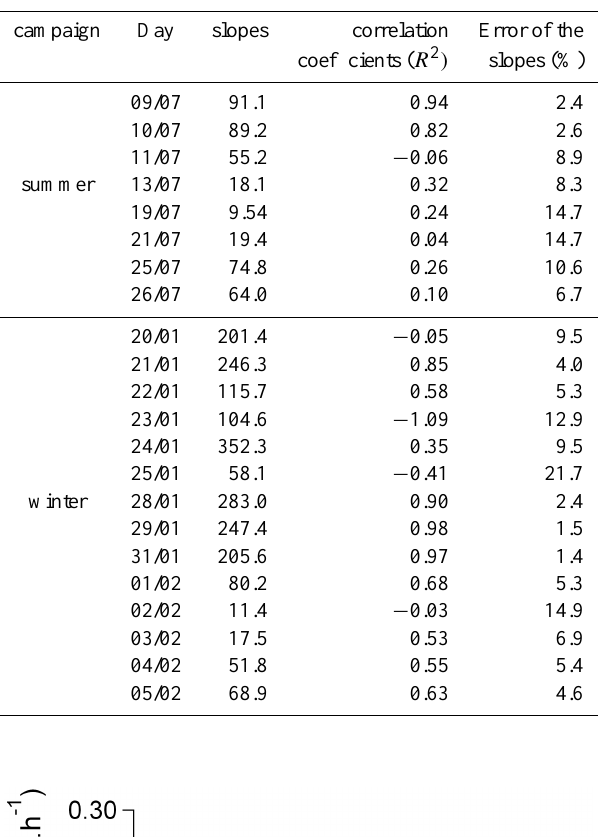
Table 3. Slopes, correlation coefficients and relative error of the slopes of the correlations between the calculated unknown HONO source and J (NO 2 ) for each days of the summer and winter cam- paigns campaign